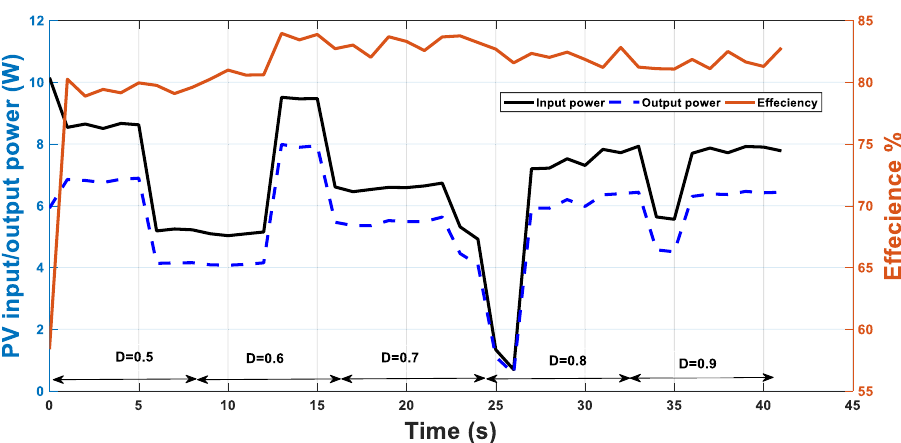
Figure 14. Fixed MPPT with temperature and irradiance variation in one-day morning with